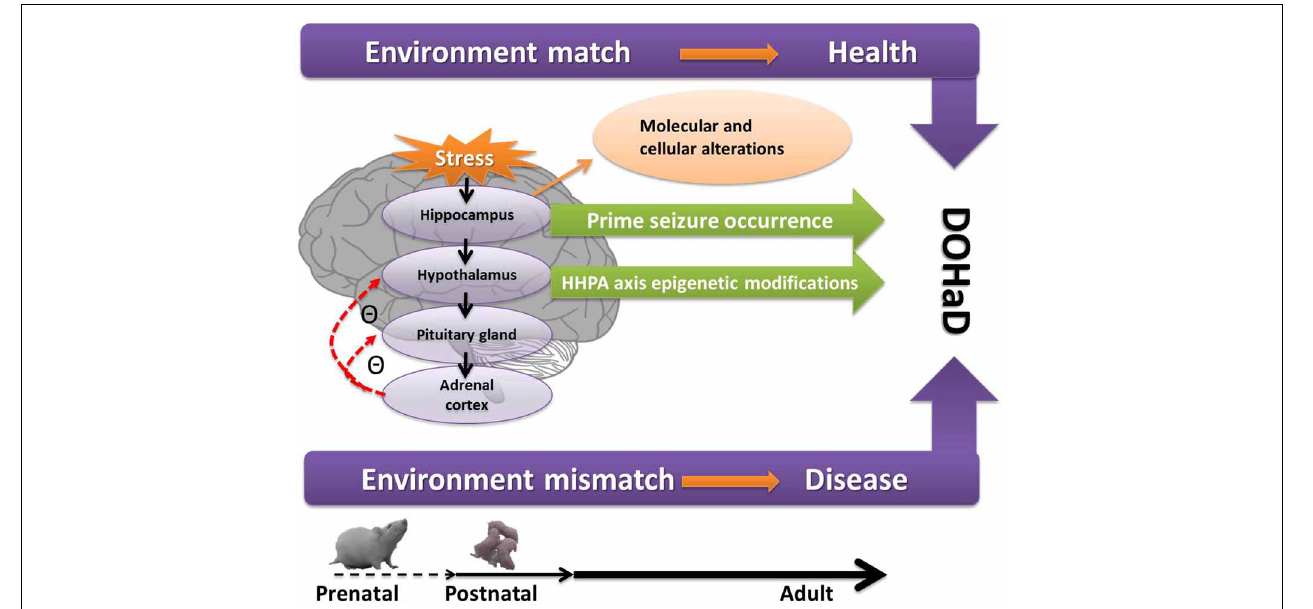
FIGURE 1 | A conceptual diagram of how prenatal and postnatal stress act on the hippocampus and HPA axis and lead to neuropsychiatric disorders through epigenetic modifications, the so-called DOHaD as presently understood. If the early programming environment matches the later adult environment, the adults are